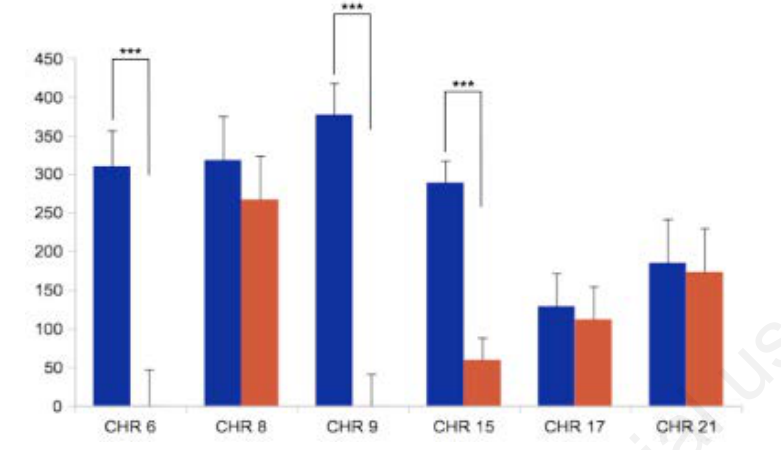
Figure 2. Comparison of inter-homologue distances between the two cell types. Chromosomes are in the x-axis, while distances are reported in the y-axis. Distances are normalized in the plot. HSCs' chromosomes are in blue while myeloid precursors' chro- mosomes are in